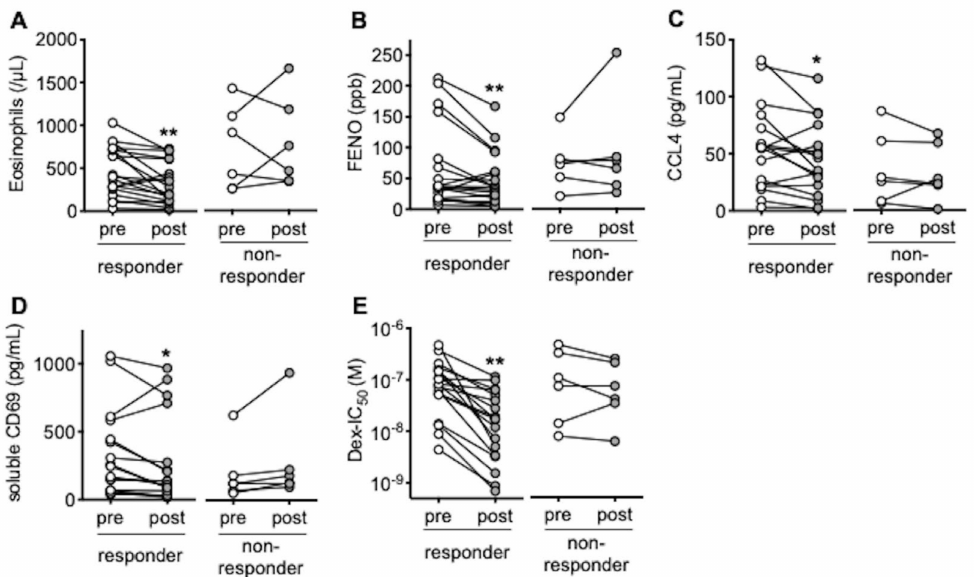
Figure 1. Effects of omalizumab on clinical markers and corticosteroid sensitivity. Peripheral blood eosinophil counts ( A ), FENO ( B ), serum CCL4 levels ( C ), serum-soluble CD69 levels ( D ), and IC 50 values for dexamethasone on TNF α -induced CXCL8 production (Dex-IC 50 ) in PBMCs, a marker of corticosteroid sensitivity ( E ), were evaluated pre- and post-treatment with omalizumab. Individual values of the responder group ( n = 19) and the non-responder group ( n = 6) are shown; * p < 0.05, ** p < 0.01 (vs. pre-treatment).